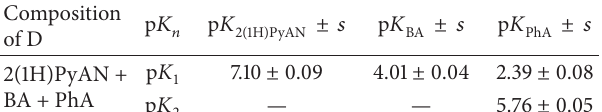
Table 9: The p 𝐾 ’s values of compounds determined in the a multicomponent mixture which comprises barbituric acid, 2(1H)- pyrazylidene acetonitrile, and phthalic acid at 25 ∘ C.